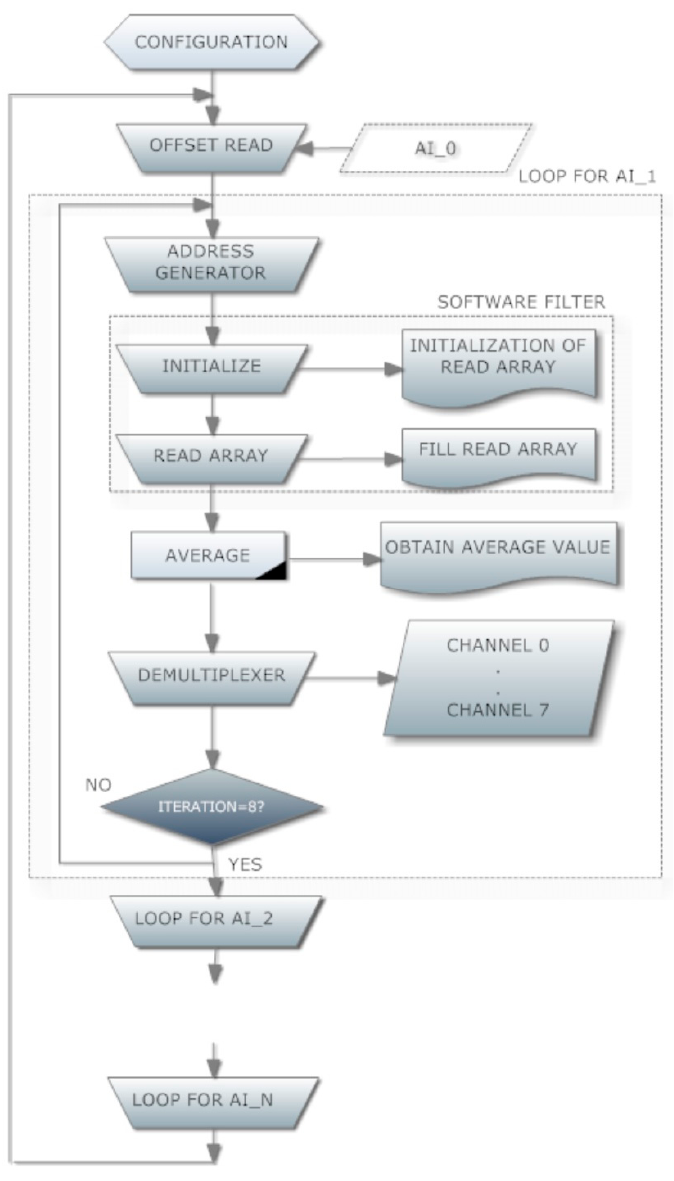
Figure 6. Flowchart of the NI LabVIEW program.